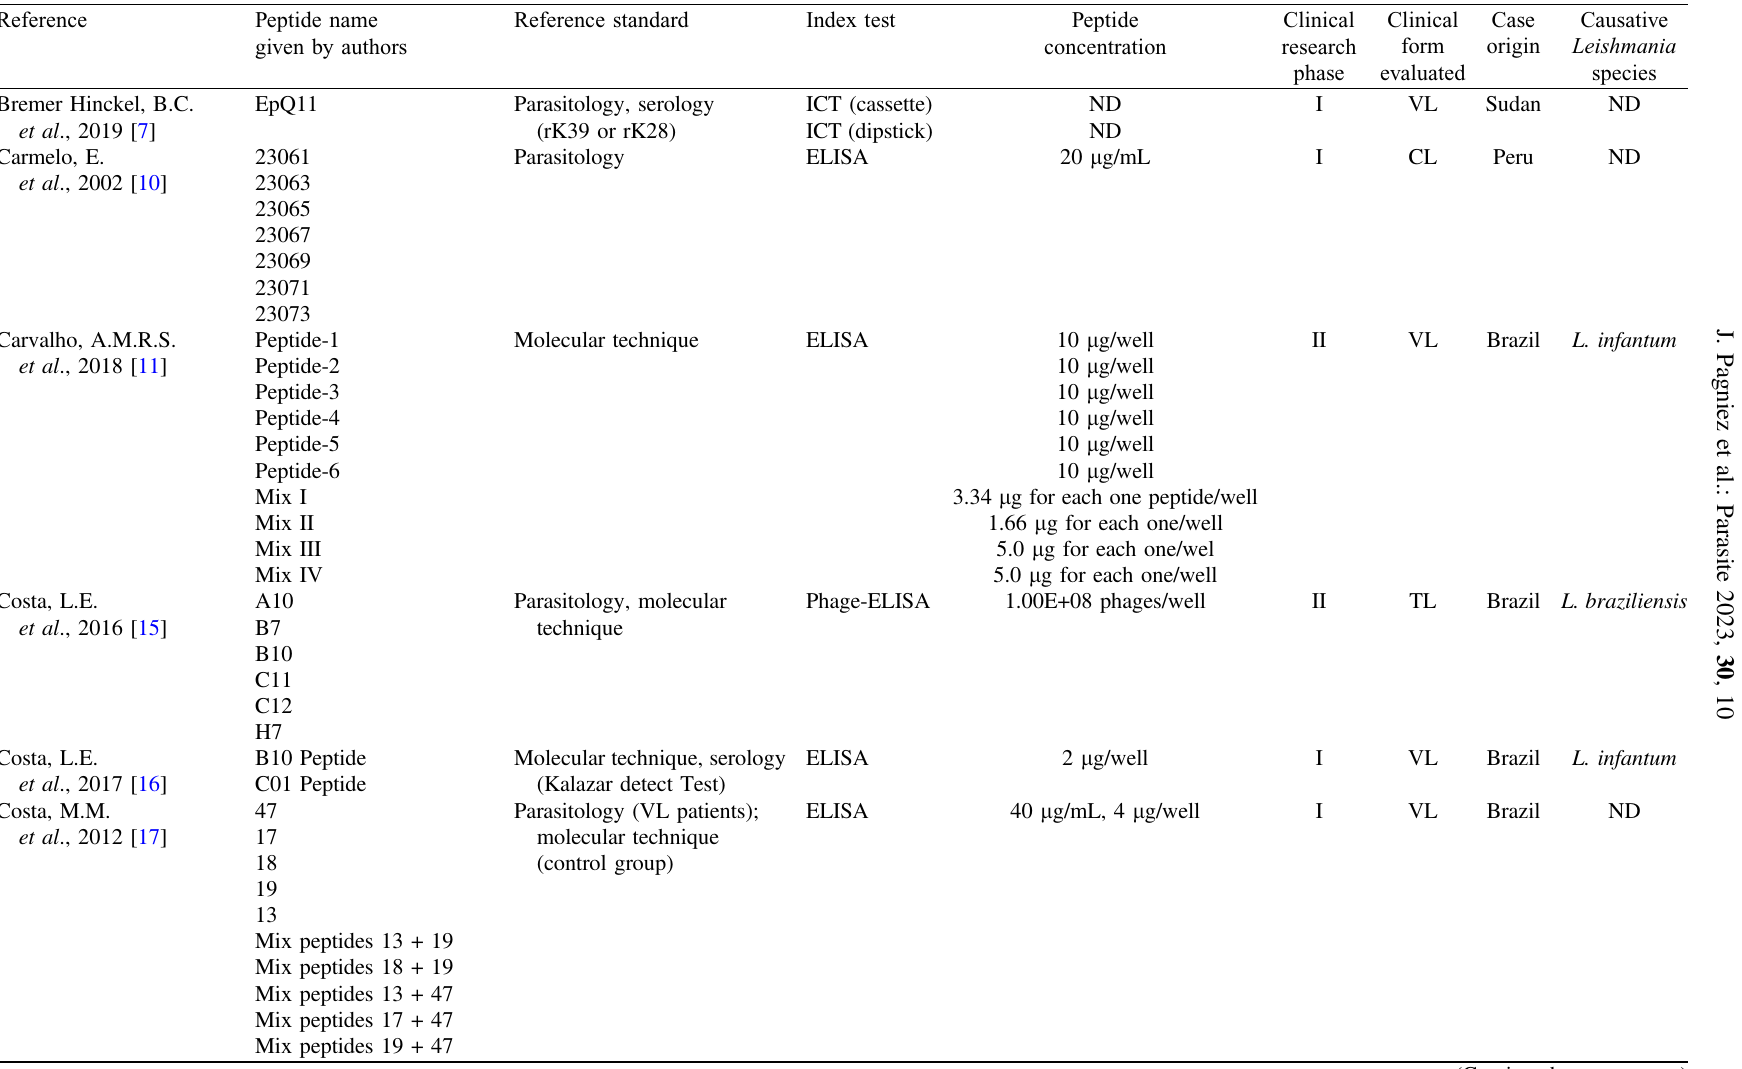
Table 1. Characteristics of included